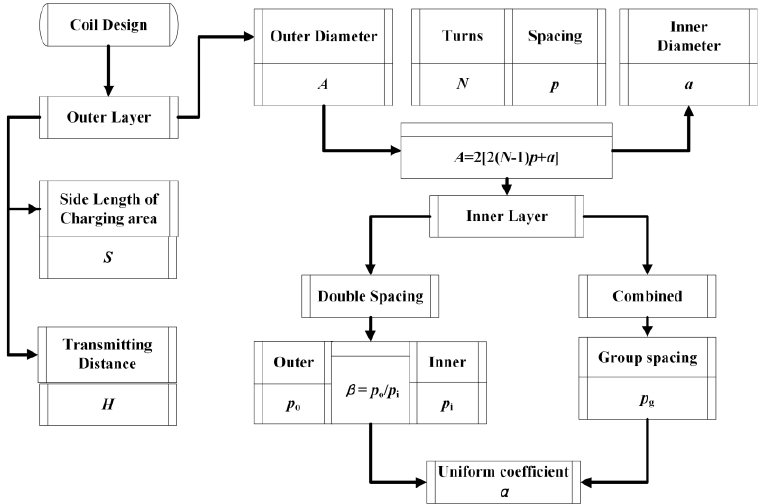
Figure 4. Flowchart of the design process.